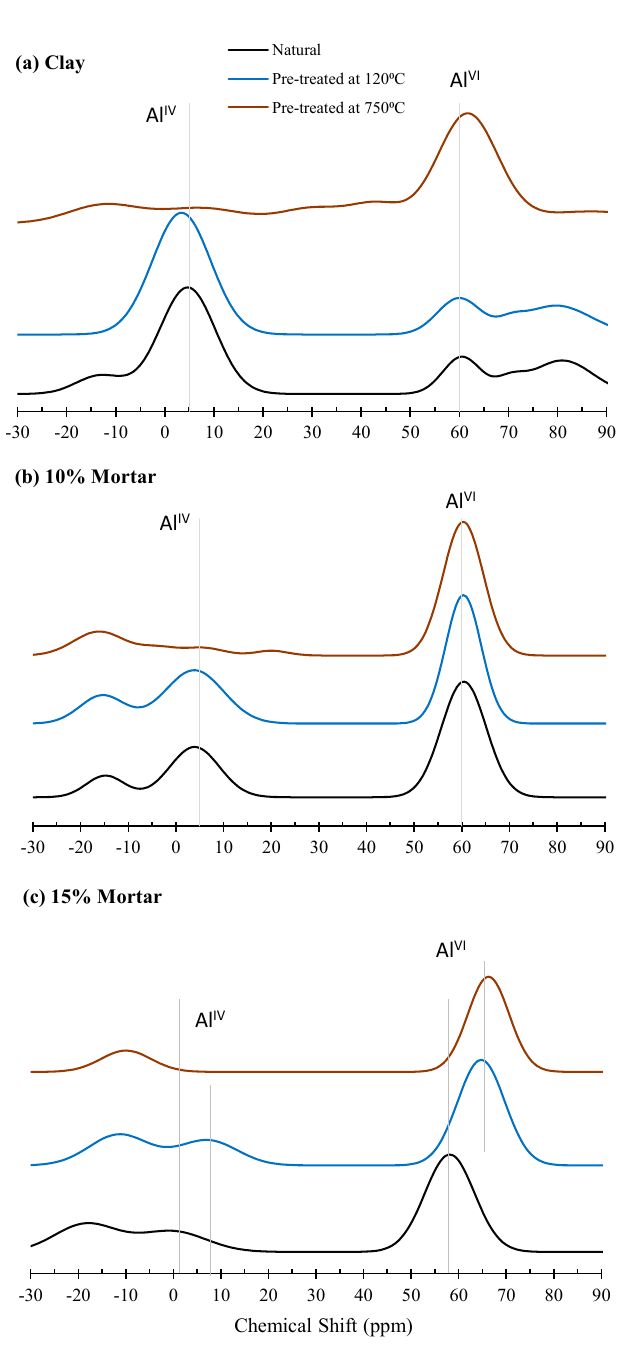
Figure 4. NMR spectra: ( a ) clay; ( b ) 10% mortar and ( c ) 15% mortar. The Al (IV)-fold coordination is assigned to the chemical shifts in the range between 60 and 80 ppm, while Al (VI) coordination is assigned to the chemical shifts observed between 3.5 and 5.0 ppm. For the 10% dosage specimens, the untreated clay/natural clay powder showed a distinct Al (VI) coordination peak at 4.8 ppm. This shifted to 3.5 ppm when clay was pre-treated at 120 °C. No change was noted in the Al (IV) peaks following treatment at 120 °C. In the clay treated at 750 °C, all of the aluminum was observed to be in the Al (IV) coordination state, being converted during the calcination process. The de- convoluted data show that the untreated natural clay contained 61.6% Al (VI) and 38.4% Al (IV). Following pre-treatment of clay at 120 °C, the Al (VI) coordination increased to 67.6%, with a corresponding decrease in the Al (IV) coordination, as shown in Table 5.